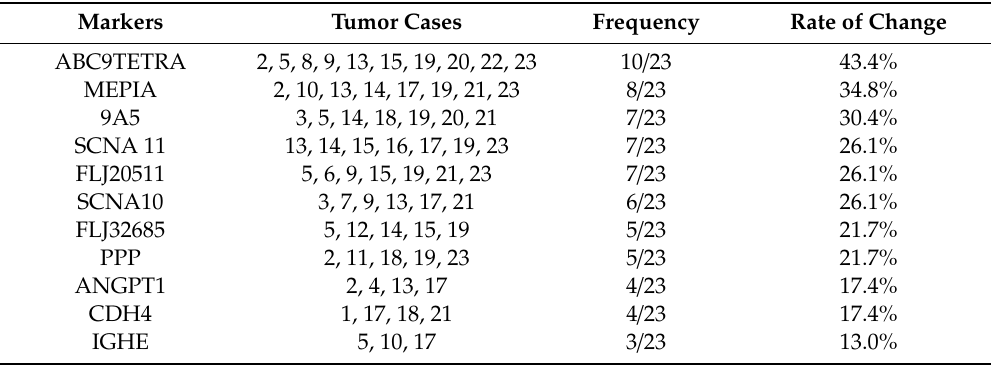
Table 5. Frequency of MSI for each microsatellite marker.